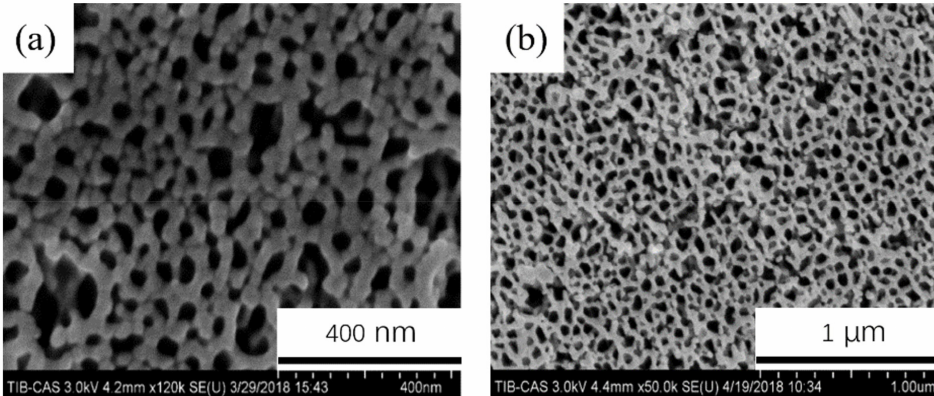
Figure 10. SEM images of 7075 anodic oxide films at different electrolyte concentrations: ( a ) 4 wt%; ( b ) 10 wt%.